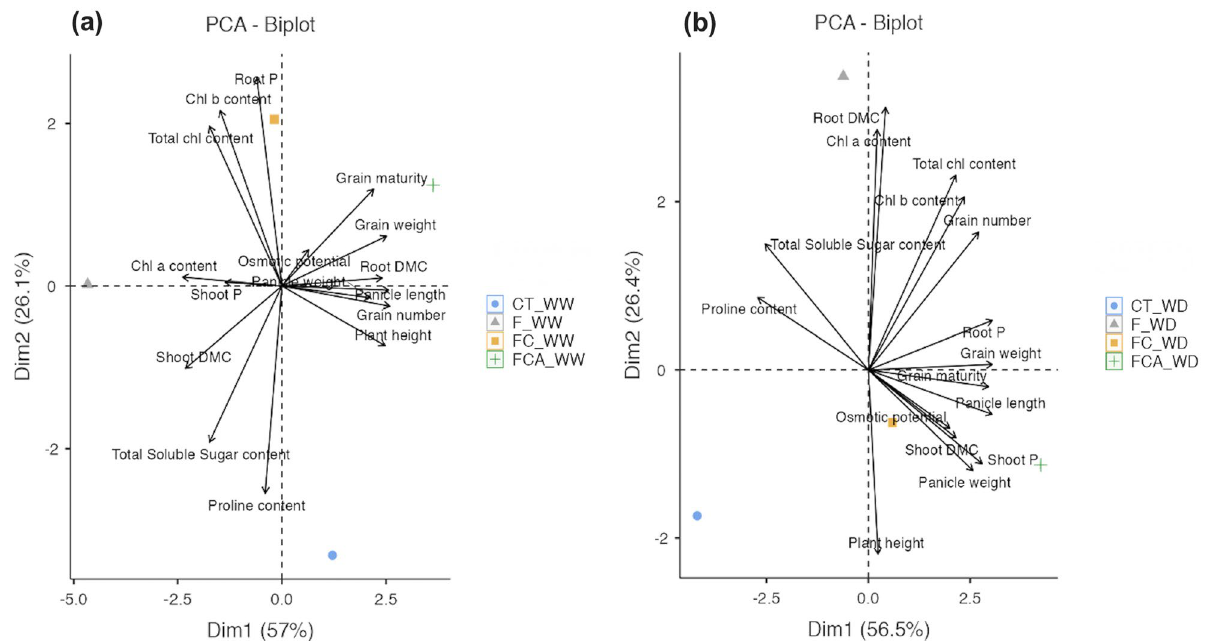
Figure 6. Principle component analysis depicting score and loading plots of the experimental physiological and biochemical parameters, growth, panicle-grain production/quality, and dry matter content (DMC) in rice cv. Leum Pua inoculated with or without AMFs (F, FC, FCA, and CT) and on the 21st day of well-watered (WW, a ) and water deficit (WD, b )